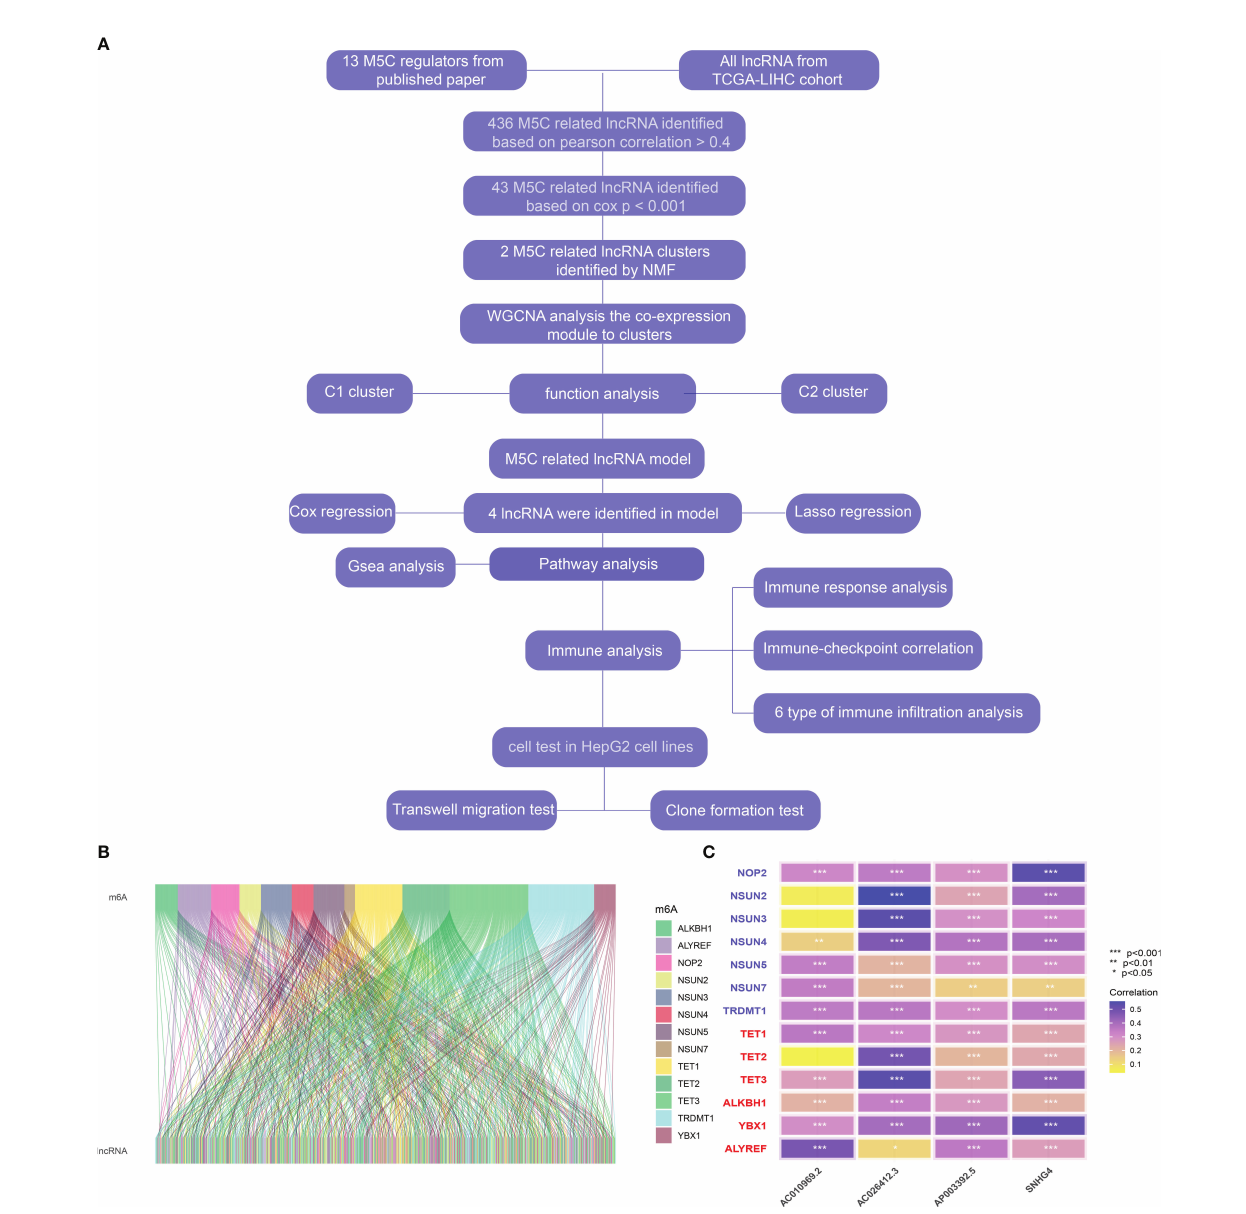
FIGURE 1 | (A) Flow chart of this study. (B) Correlation between m5C correlated genes and lncRNA in hepatocellular carcinoma. (C) Heatmap of correlation between m5C-related genes and four prognostic m5C-related lncRNAs * represents p value < 0.05, ** represents p value < 0.01, *** represents p value < 0.001, ns means not statistically signi fi